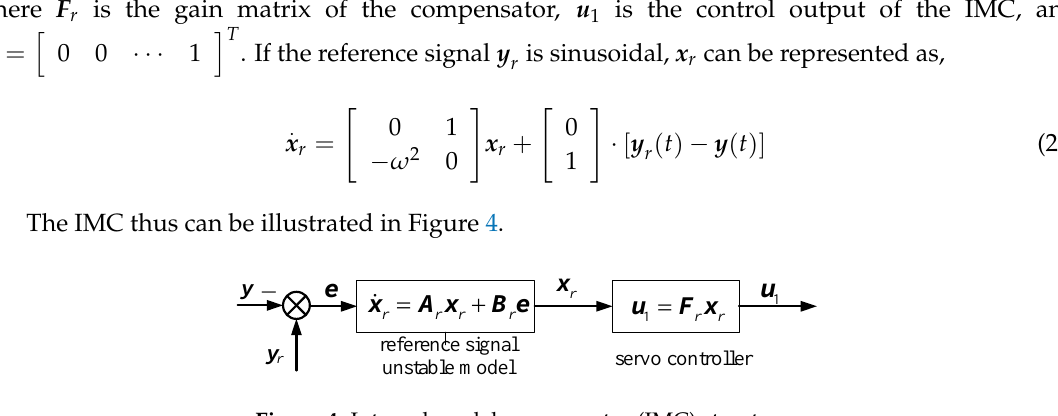
Figure 4. Internal model compensator ( IMC) structure.